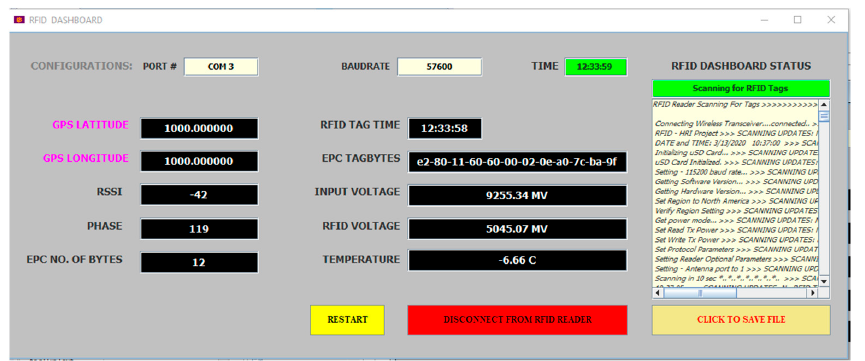
Figure 4. The RFID dashboard display. On the right of the display is the text file showing the RFID reader settings.